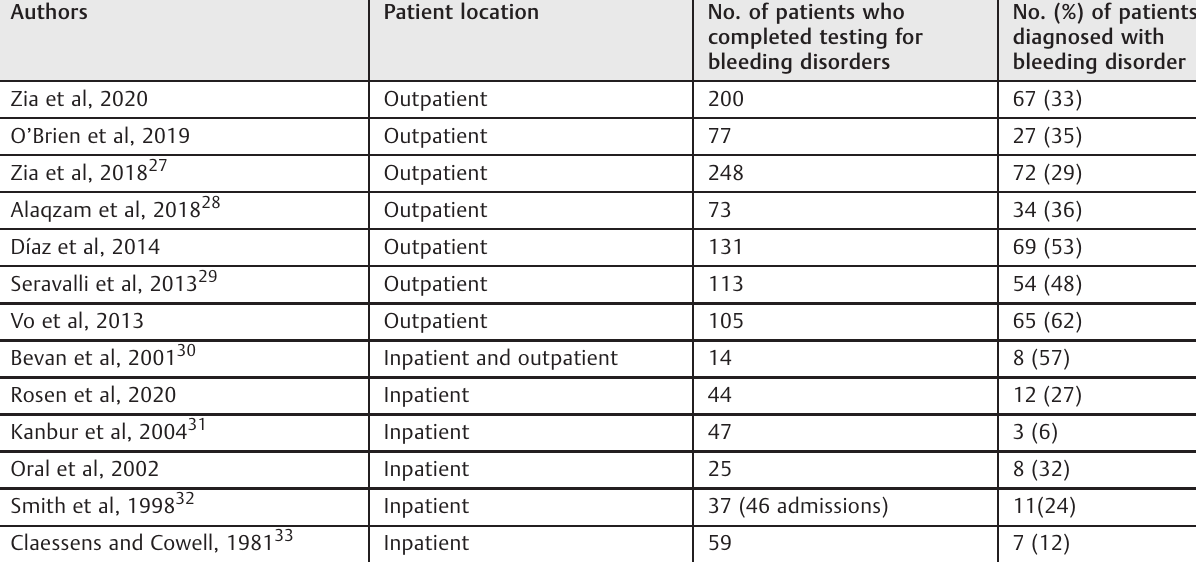
Table 3 Prevalence of bleeding disorders in patients with heavy menstrual bleeding in outpatient or inpatient outings.